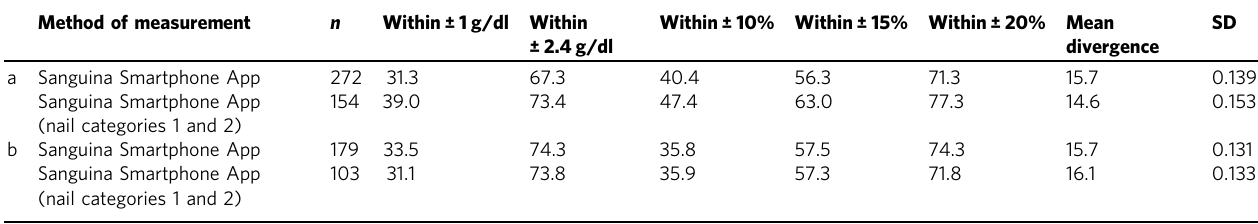
In-range-method for App measurements showing the percentage of observations (%) within a de fi ned range of deviation from the reference method (±1g/dl, ±2.4g/dl, ±10%, ±15% and ±20%), the mean divergence (%), and standard deviation (SD) of divergence; a clinic-based sample, b pre-school sample.